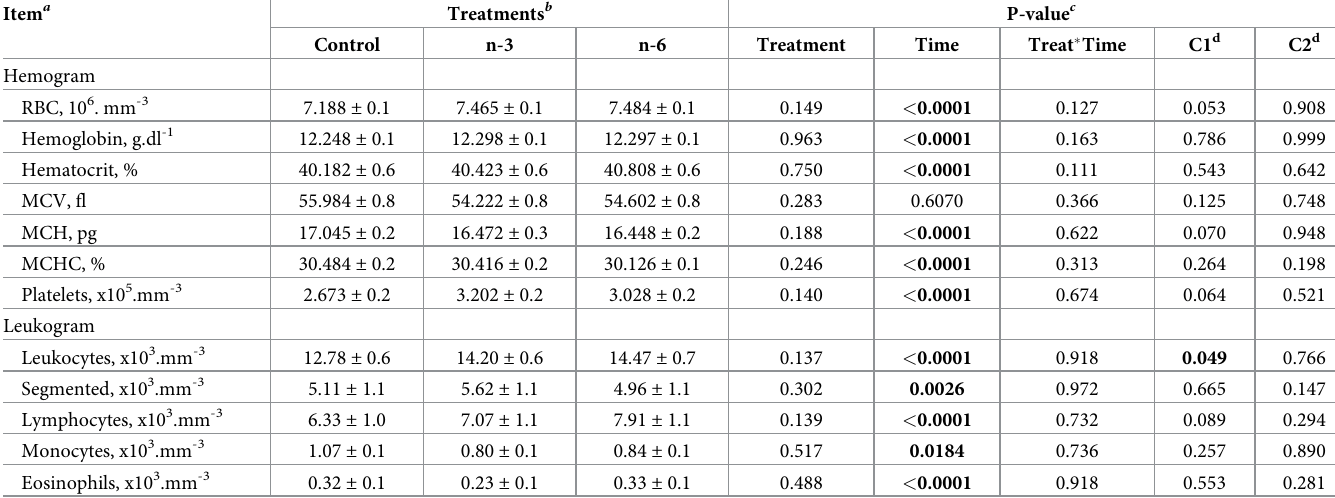
Table 6. Effect of supplementation of milk enriched with n-3 and n-6 on hemogram and leukogram of gilts from 34 to 190 days of age. Item